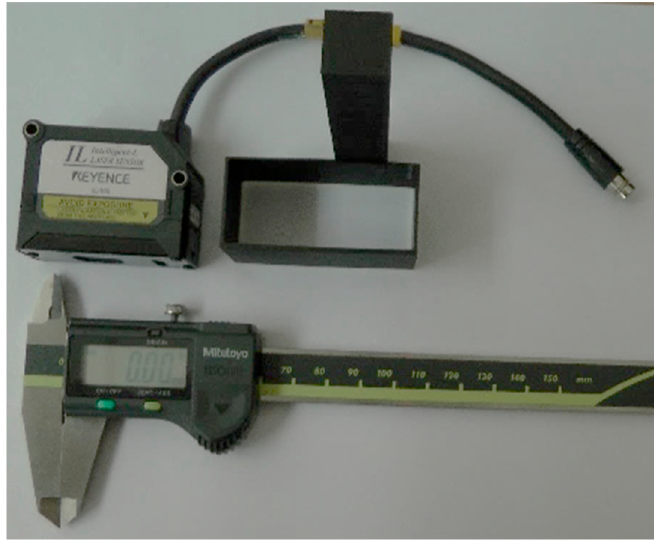
Figure 7. LTS with 3D-printed sensor holder.